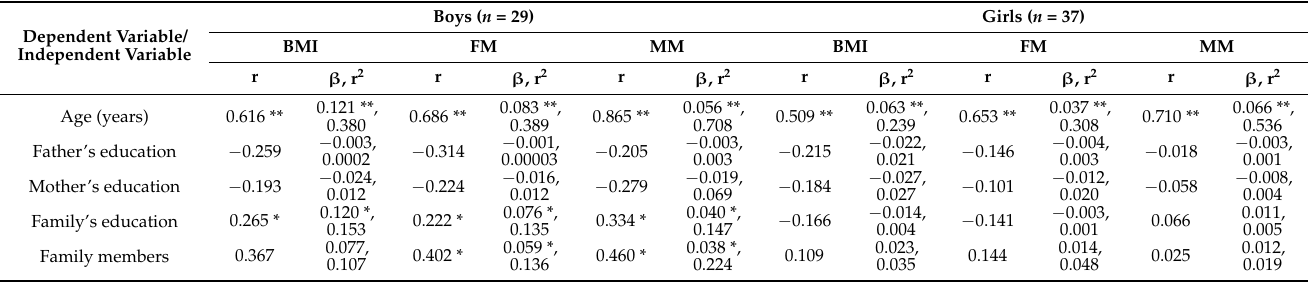
Table 6. Spearman correlation coefficient and simple linear regression analysis between demographic data and some anthropometric indices of children ( n = 66) with CD following the Ministry of Health GFD program for boys and